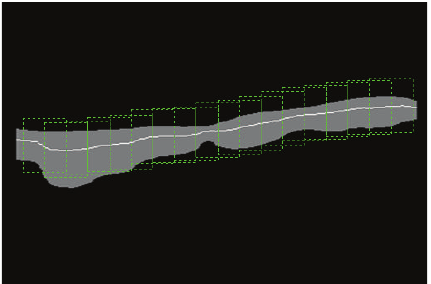
Figure 5: Regions overlapping midway are assigned along the longitudinal direction of the vessel